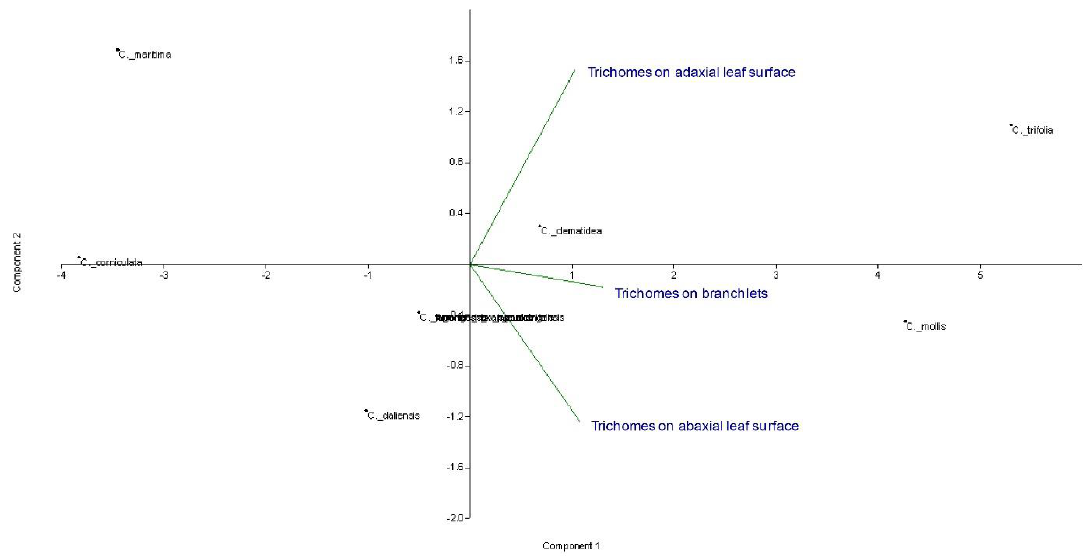
Table 5. PCA of selected species of Causonis .